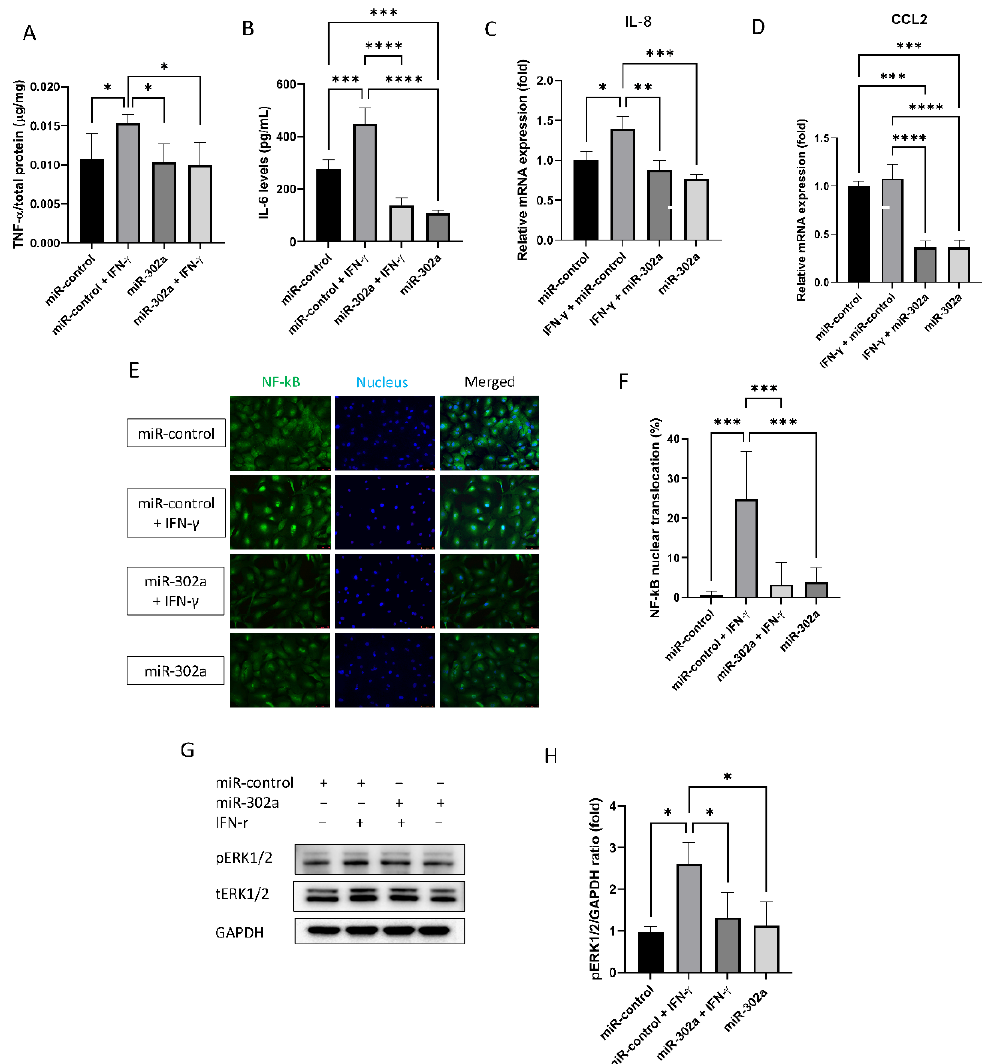
Figure 3. Effect of miR-302a on senescence-associated response. Senescence-associated secretary phenotype secretion ( A , B ) was measured in conditioned medium. ( C , D ) mRNA expression of IL-8 and CCL2 was evaluated by real-time PCR. ( E , F ) Nuclear factor- κ B (NF- κ B) translocation was evaluated using immunofluorescence staining. Scale bar = 75 µ m. ( G , H ) Activation of extracellular- signal-regulated kinase (ERK) 1/2 was evaluated with or without IFN- γ or miR-302a. Data presented as mean ± S.D. * p < 0.05, ** p < 0.01, *** p < 0.001 and **** p <